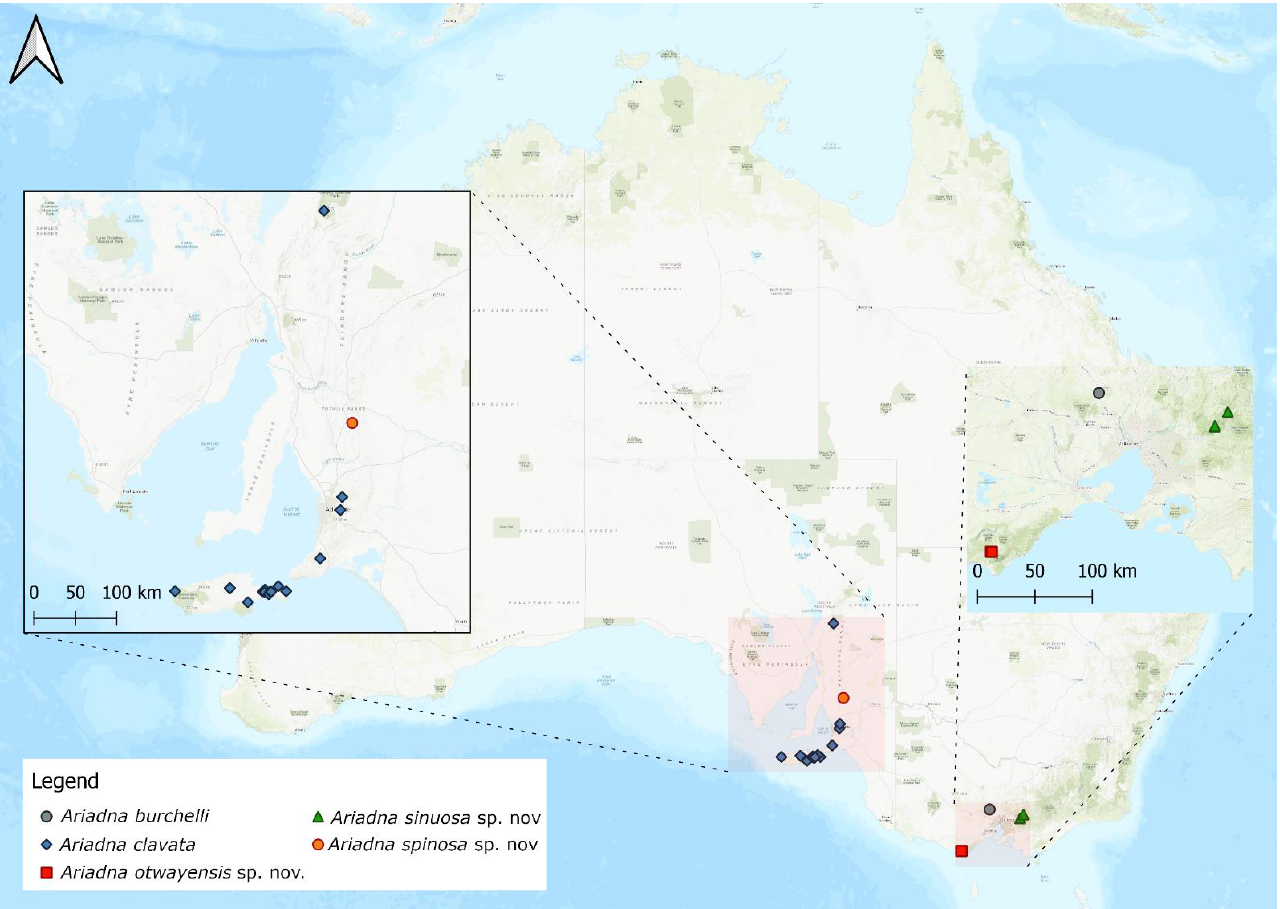
Figure 8. Map showing the currently known distribution of A. burchelli, A. clavata, A. sinuosa sp. nov., A. otwayensis sp. nov. and A. spinosa sp. nov. Ariadna spinosa sp. nov.